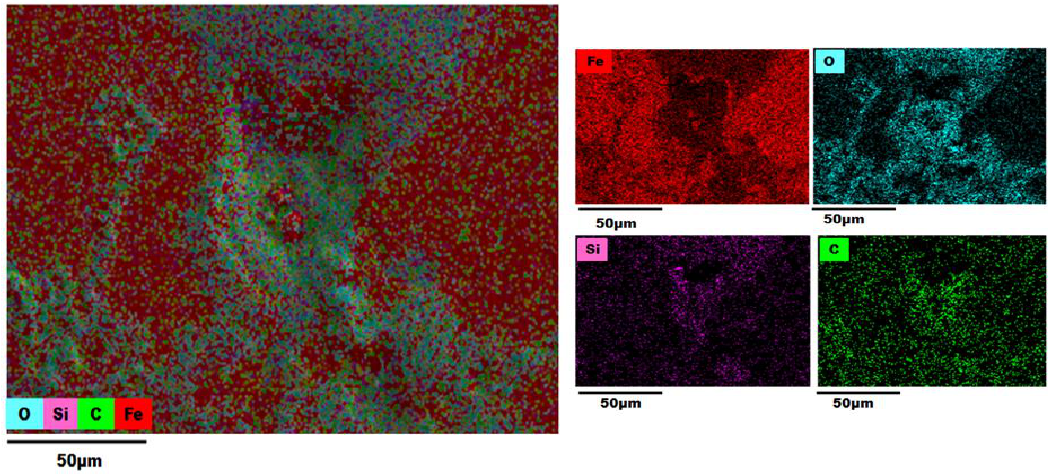
Figure 15. EDS map of a 90° elbow exit surface after the test for 10 wt.% sand fines concentration.